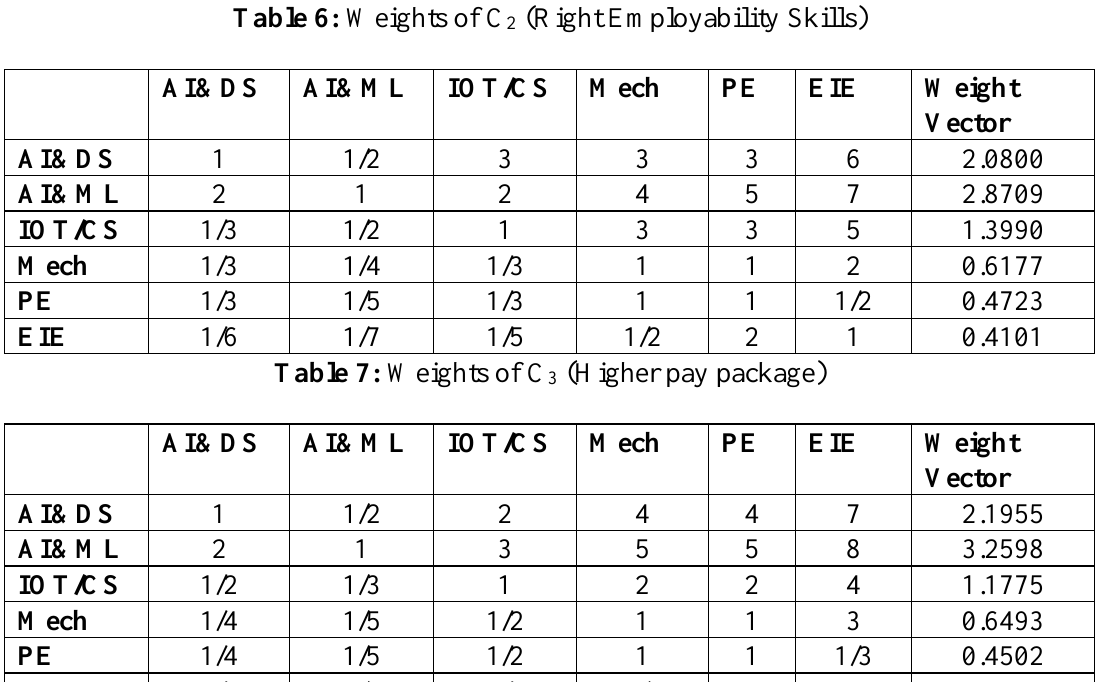
Table 6: Weights of C